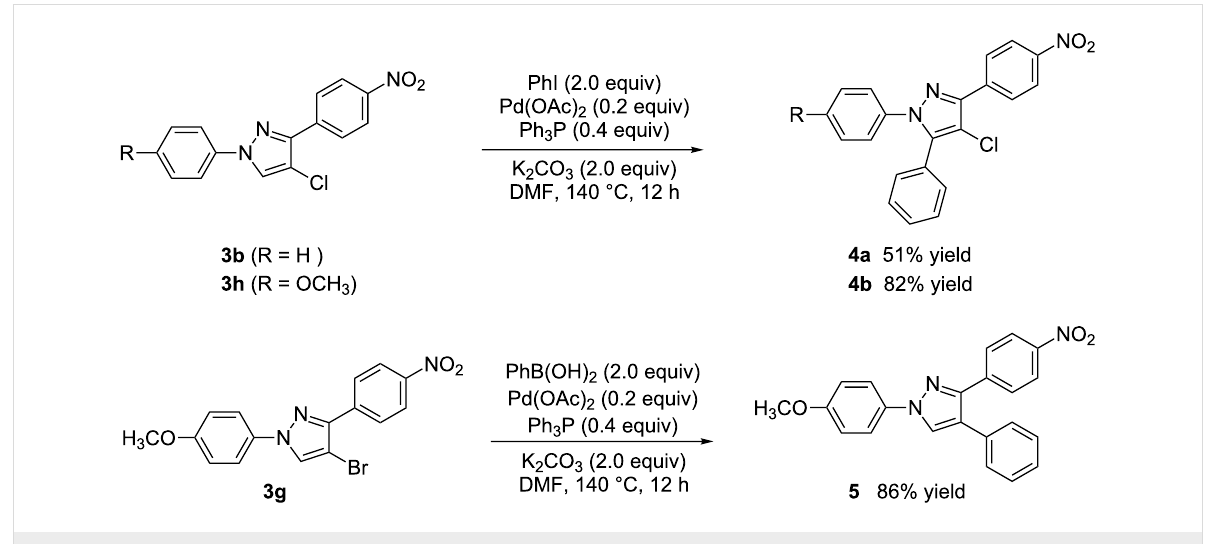
Scheme 3: Arylation reactions of pyrazoles ( 3 ) with iodobenzene or phenylboronic acid.